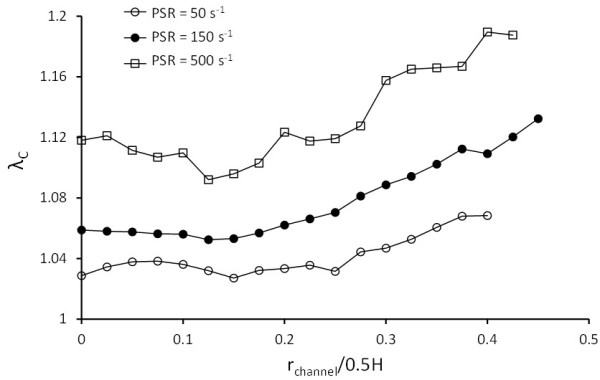
Relation between cell perimeter extension ratio λC and its transverse location rchannel in the channel. RBCs further away from the channel centerline undergo larger deformations due to the higher shear rates near the channel walls.